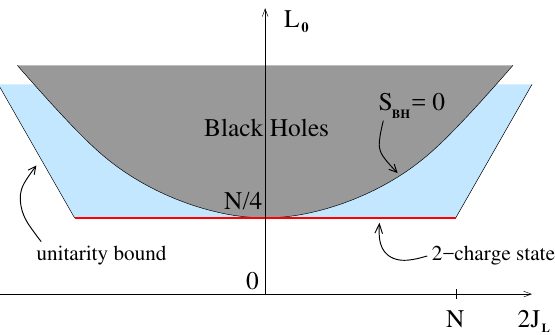
( L 0 (cid:0) c ) (cid:29) j 2 , are microstates with the same L 6 24